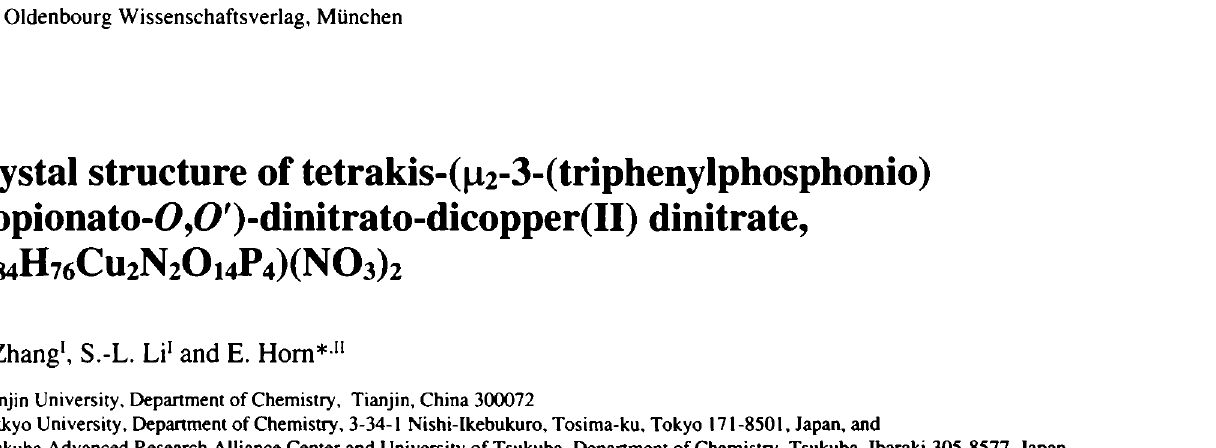
Table 1. Data collection and handling.